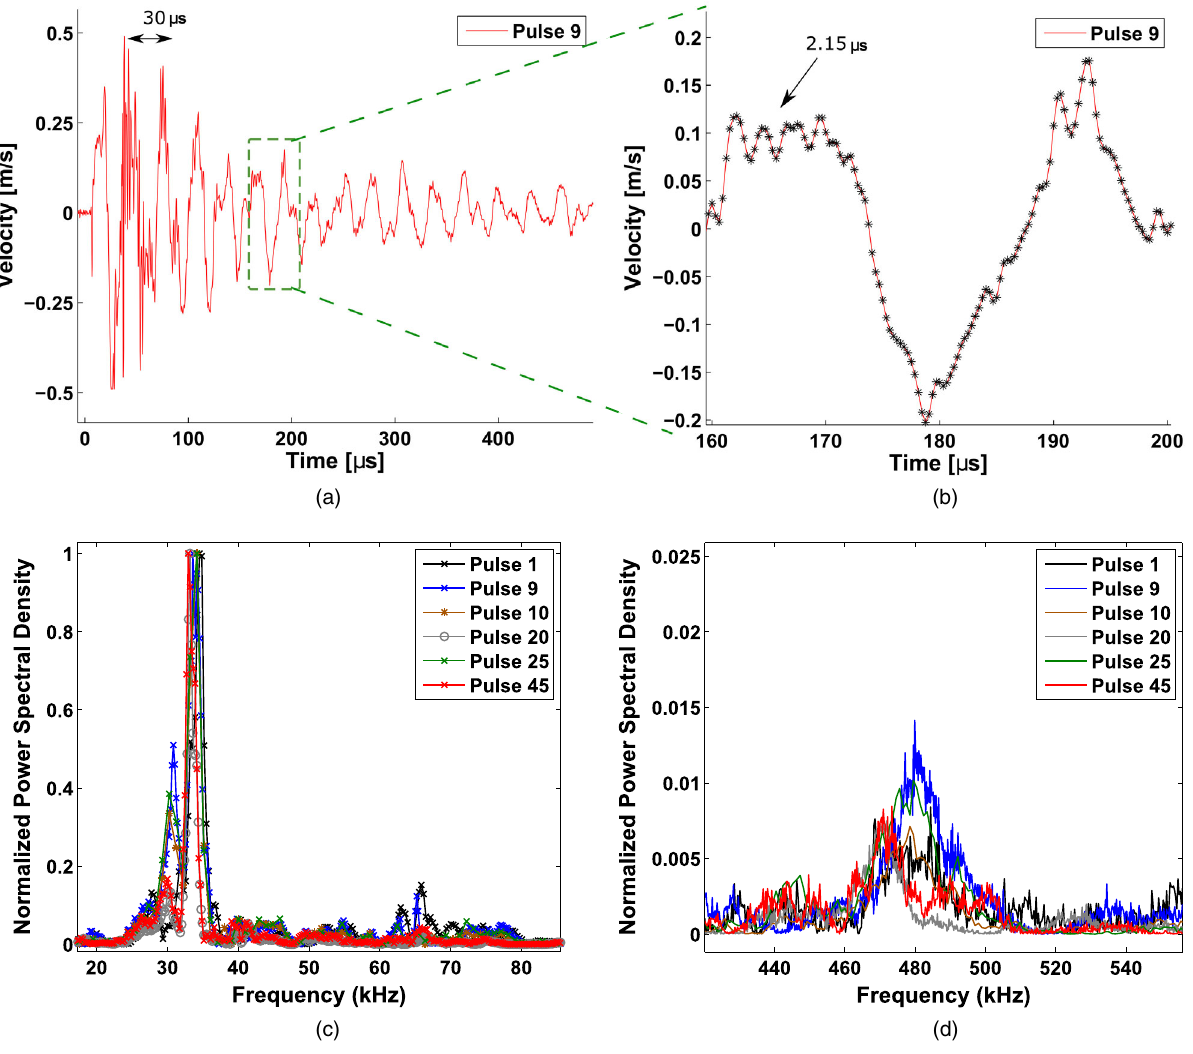
FIG. 8. (a) Example of radial velocity recorded at the HRMT-42 target periphery by the LDV during the ninth impacted pulse. (b) Zoom-in of the recorded velocity showing the high frequency component of the recorded velocity. This is attributed to the radial mode of vibration of the Ta core which propagates towards the target periphery through the EG matrix. (c) Frequency domain of the velocity recorded by the LDV for different impacted pulses, showing the low frequency range. Components within 30 – 35 kHz identified as radial modes of vibrations of the whole target dominate the velocity response. (d) Zoom-in of the frequency domain of the recorded velocity showing the high frequency range. A peak within 470 – 480 kHz can be observed which is identified as the radial mode of vibration of the Ta